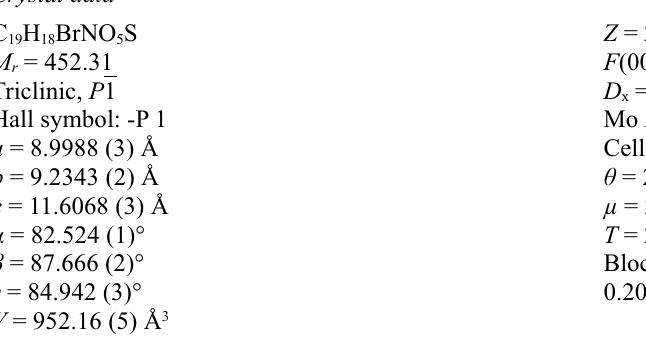
The packing of I , viewed down the a axis. Intermolecular H–bonds are shown as dashed lines H atoms not involving hydrogen bonding have been omitted for clarity. [Symmetry codes: (i) - x +1, - y +1, - z +2; (ii) x , y +1, z ]. Ethyl 2-(bromomethyl)-5-methoxy-1-phenylsulfonyl-1 H -indole-3-carboxylate Crystal